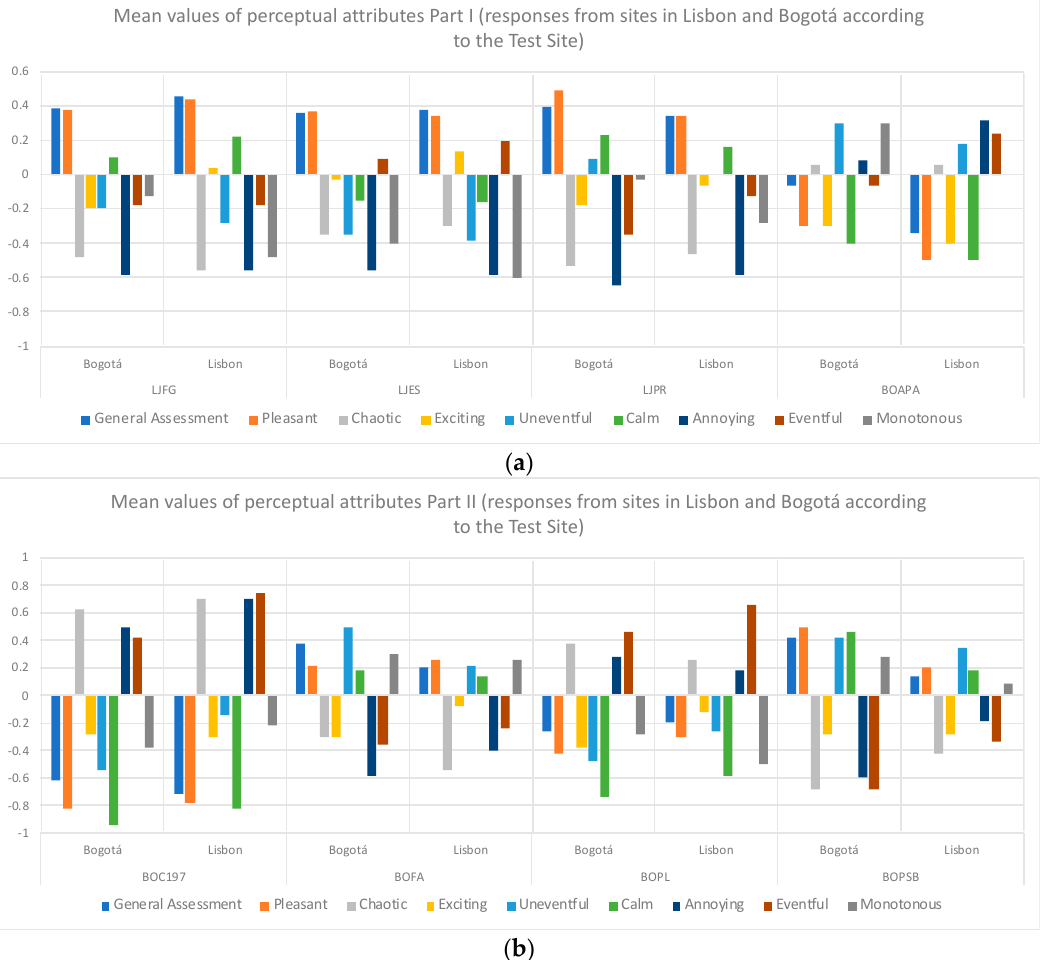
Figure 4. ( a ) Mean values of perceptual attributes Part I (responses from sites in Lisbon and Bogotá according to the listener’s Test Site); (b) Mean values of perceptual attributes Part II (responses from sites in Lisbon and Bogotá according to the listener’s Test Site). Table 2. Results of the U Mann-Whitney test with = 0.05 for evaluators from Bogotá and from Lisbon. Green values represent statistically significant differences in the responses according to listener origin. Shaded values represent the highest average rank value between listeners in Bogotá and Lisbon.